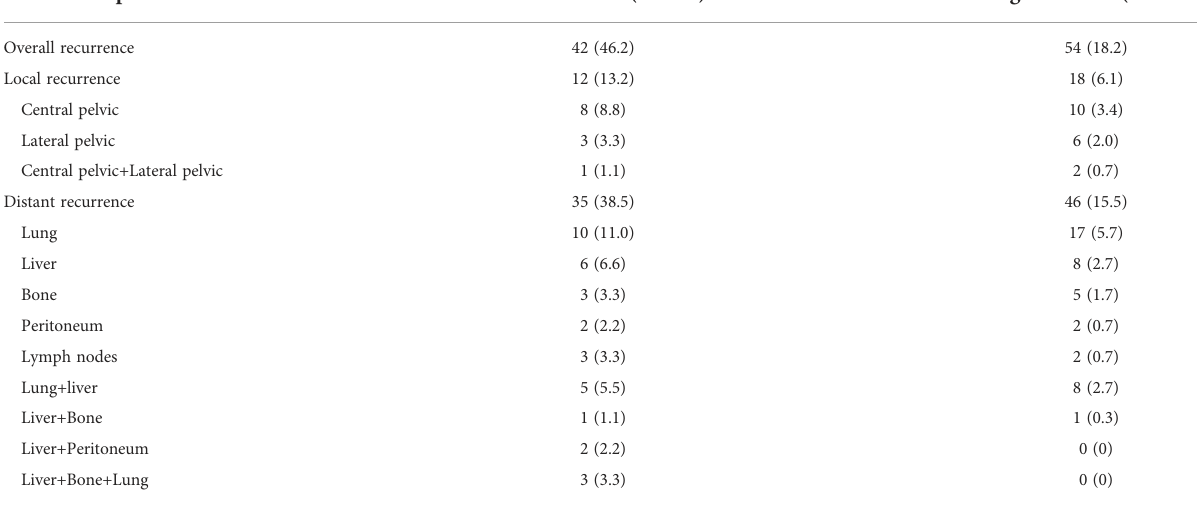
TABLE 5 Recurrence rate of local and distant